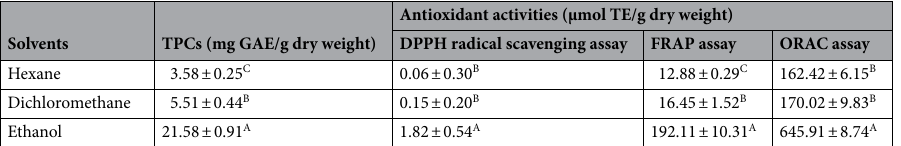
Table 1. Total phenolic contents (TPCs) and antioxidant activities of D. esculentum extracted with gradually increased polarity index solvents. Data are presented as mean ± SD of three independent experiments. Capital letters within a column for a given parameter are significantly different at p < 0.05. The final concentration of the extract was 1.25